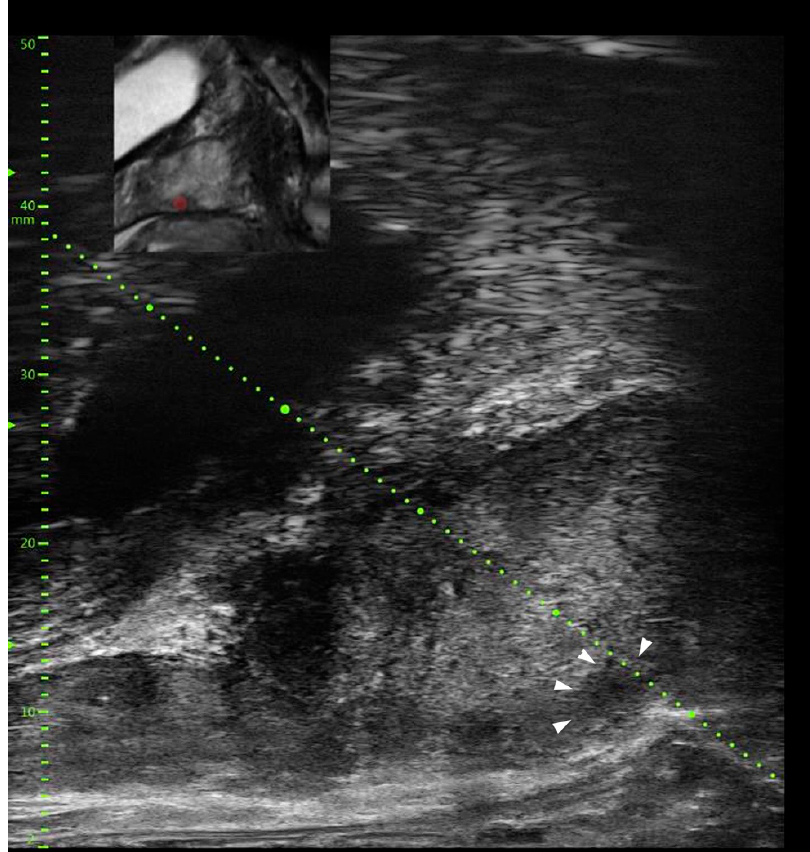
Figure 3. MRI lesion (red dot on MRI image in the upper left corner) is clearly visualized in real-time on microUS (outlined by the arrowheads) and provides the operator the confidence that the lesion found on MRI is the same as seen on microUS. Additionally, mpMRI/microUS fusion is beneficial in targeting MRI suspicious sites in the anterior gland, which may not be visible on microUS in real-time for biopsy.